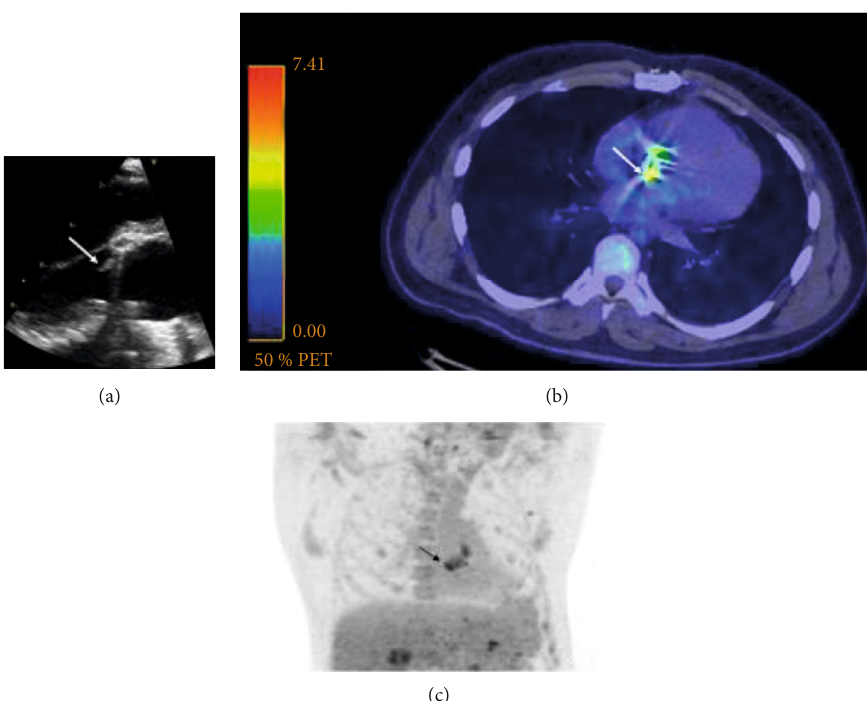
Figure 1: Transesophageal echocardiography image of patient 1 (panel (a)); arrow shows vegetation. 18 F-FDG-PET/CT images of patient 1 (panels (b) and (c)). Arrows show increased 18 F-FDG uptake at the site of aortic valve (Figure 1) detected at admission with transthoracic echocar- diography (TTE). Magnetic resonance imaging (MRI) of the head revealed multiple cerebral hemorrhagic lesions and an abscess in the cerebellum. Embolic infarctions were detected in the spleen and in both kidneys by computed tomography (CT). Blood cultures taken on admission yielded Candida albicans on day 4, and therapy with liposomal amphotericin B (LAMB) was started. 18 F-FDG-PET/CT of the thoracic region was performed on day 19. Injected dose of 18 F-FDG was 392 MBq and 47 minutes later, a whole-body PET acqui- sition (3min per bed position) was performed following low- dose CT scan without contrast. High focal uptake was detected at the site of the mechanic aortic valve with a max- imal standardized uptake value (SUV ) of 7.4 g/mL max (Figure 1). The patient died on day 30 after admission due to massive intracerebral hematoma.